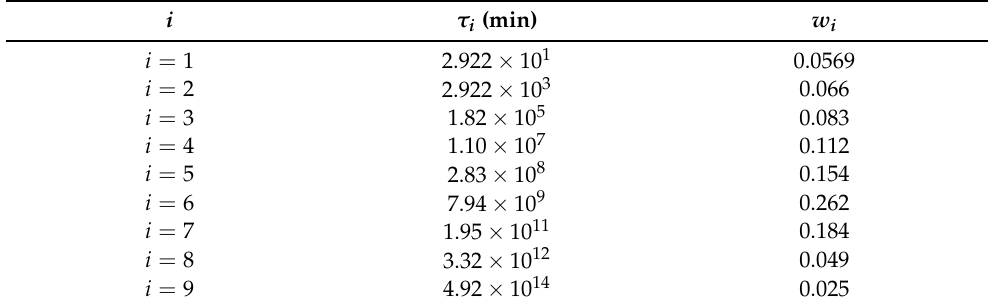
Table 4. Relaxation times and weight factors at the reference degree of cure ( a c = 0.98)